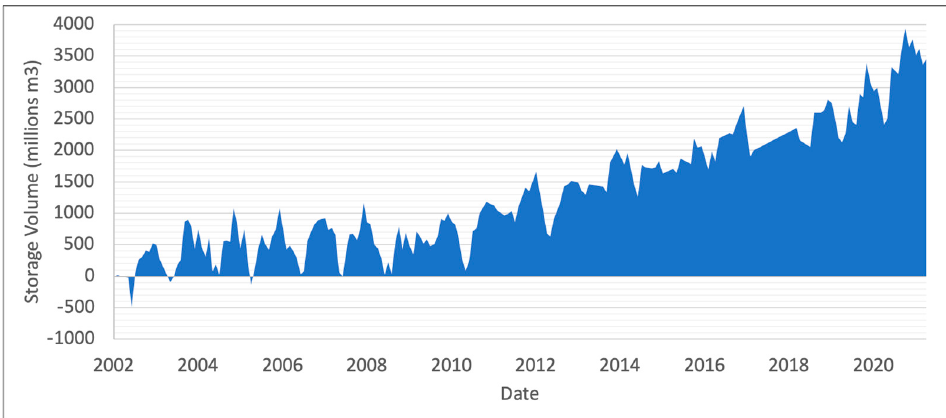
Figure 11. Volumetric storage change in the Iullemeden basin region